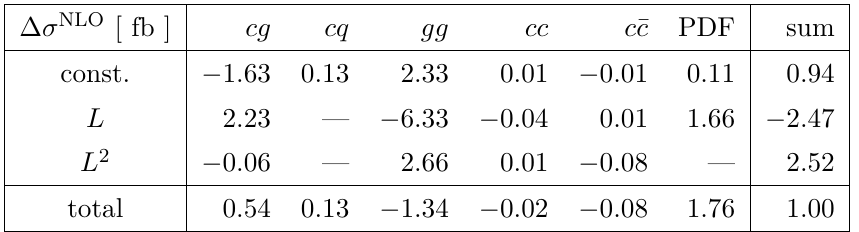
Table 1 . The NLO QCD corrections to the interference split according to partonic channels. The results are given in femtobarns. The column marked “PDF” refers to the PDF-scheme change discussed in section 2. For each partonic channel we show O ( L 2 ) , O ( L ) and O ( L 0 ) contributions where L = ln( M H /m c )